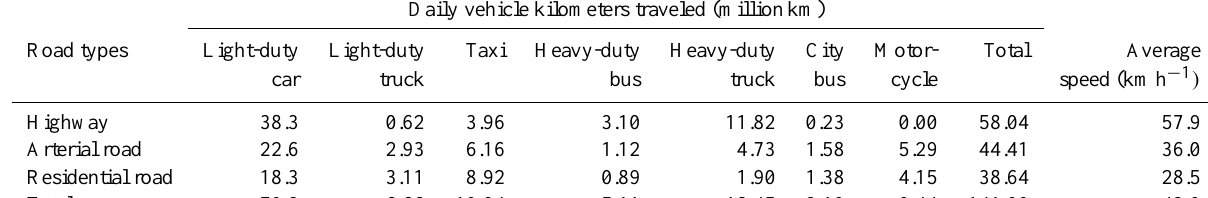
Table 1. Daily VKT and average speeds of various vehicle and road types in Shanghai in 2012. Daily vehicle kilometers traveled (millionkm)